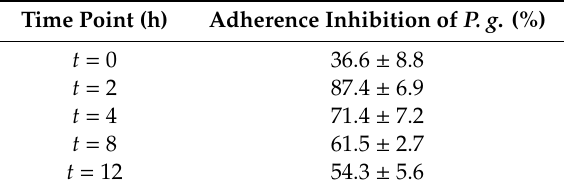
Figure 6. ( A – E ): Adherence inhibition of P. gingivalis to S. gordonii after different durations of administration. CafA-modified BAR NPs inhibited P. gingivalis adherence for over 12 h relative to CafA-modified blank NPs (control). Biofilms were visualized using confocal microscopy and the ratio to green (P. g. ) to red (S. g. ) fluorescence in z-stack images was determined using Volocity software. ( F ) CafA-modified BAR NP mediated inhibition of P. gingivalis adherence to S. gordonii at different time points in a dual-species biofilm. Error bars represent the mean inhibition ± standard deviation. Table 2. Percent inhibition of P. gingivalis adherence to S. gordonii at various time points. Time Point (h) Adherence Inhibition of P. g .